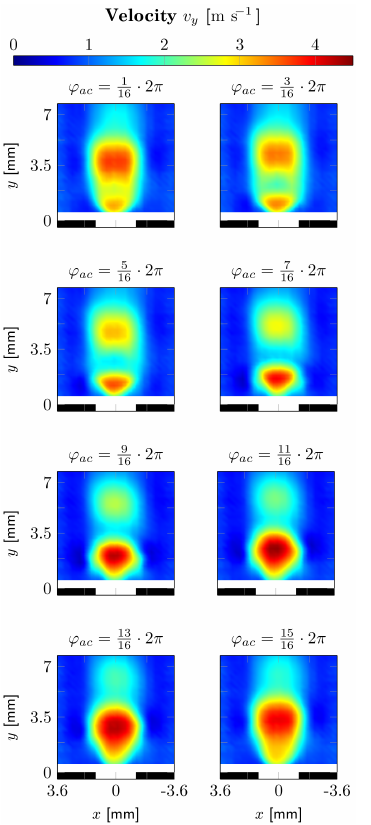
Figure 10. Phase-resolved oscillation of the flow velocity v y at z = 0mm for different phase angles ϕ ac of the sound signal.